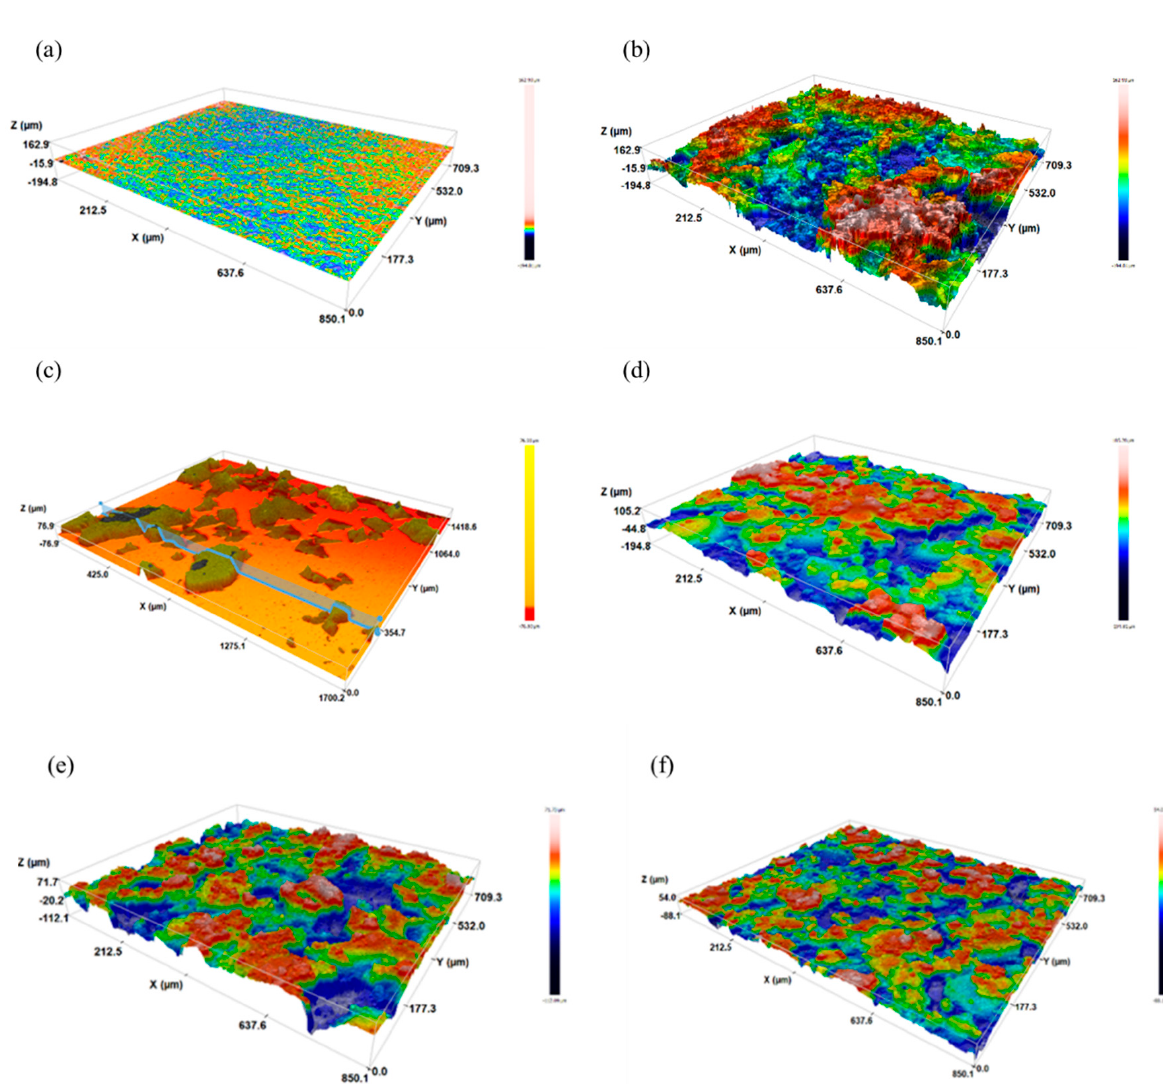
Figure 6. Confocal microscope images of Carbon-based Nanomaterials: ( a ) Graphene Oxide (GO) emulsion; ( b ) amorphous carbon powder formed using Radio Frequency Plasma Activated Chemical Vapor Deposition Method (RF); ( c ) fluorescent nanodiamond (MDCHF), ( d ) plasma–chemically modified detonated nanodiamond particles (MDP1); ( e ) chemically modified detonated nanodiamond particles with hydroxyl functional groups (MDCHPOH); ( f ) pure detonated nanodiamond particles (DND).